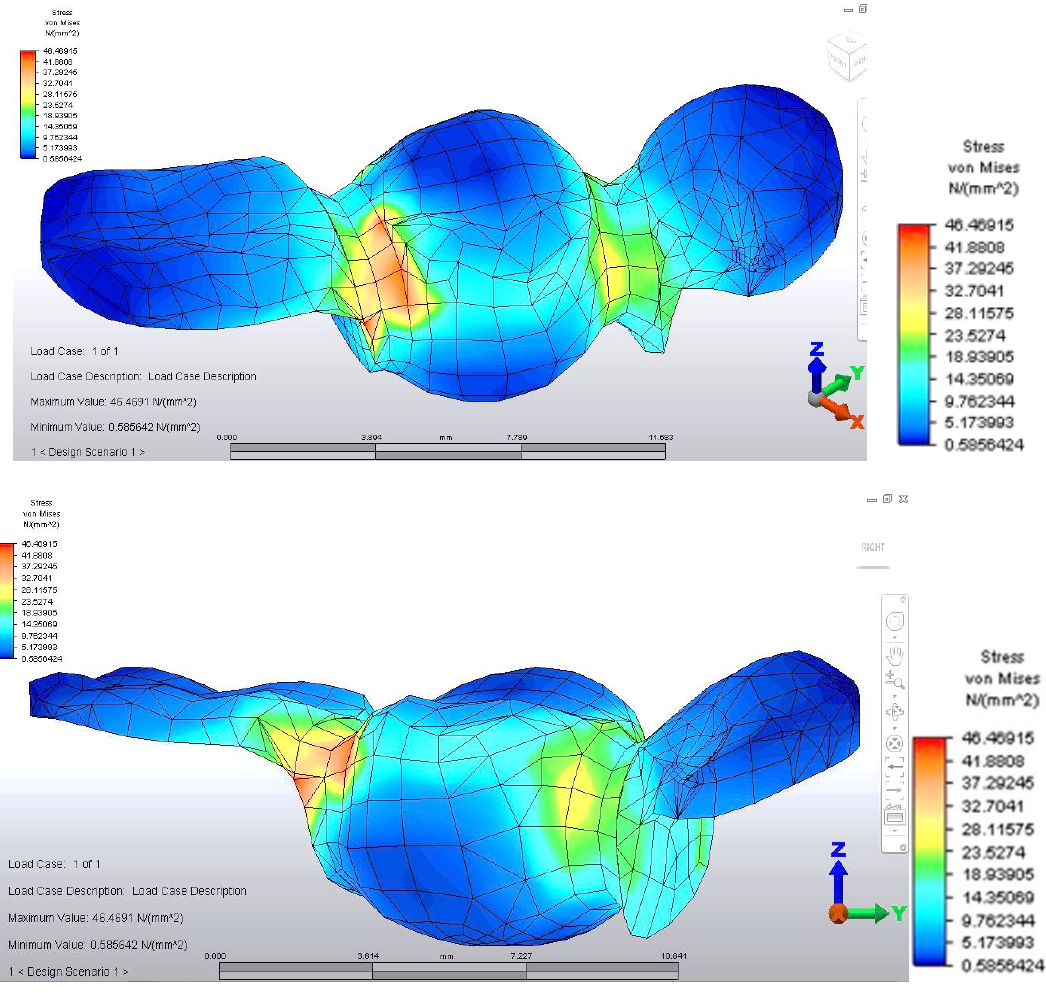
Figure 3. Tensions distribution at the bridge level, when the reaction force is placed in the 3.5